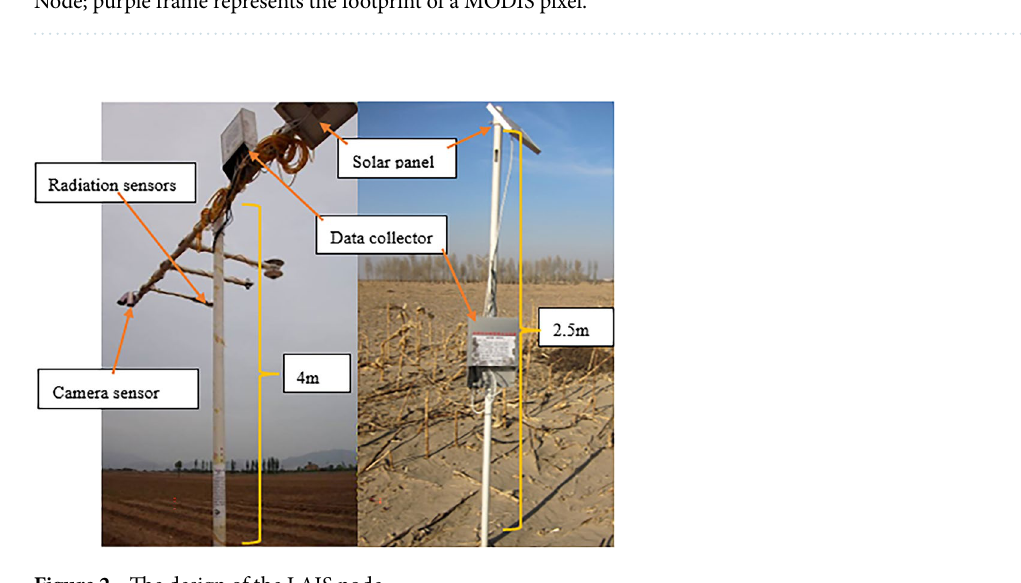
Figure 1. Equipment distribution of WSN vegetation monitoring network in Huailai (red dot represents LAIS Node; purple frame represents the footprint of a MODIS pixel.